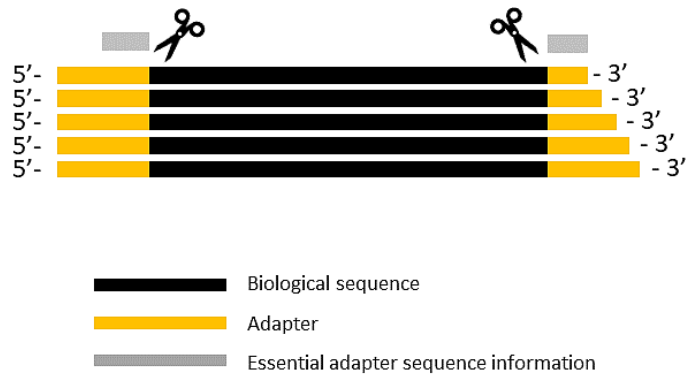
Figure 1. Essential information on adapter sequences for e ff ective trimming process. The 5 (cid:48) end adapter is usually of constant length, while the lengths of 3 (cid:48) end adapters may vary in a dataset. The exact match to the 3 (cid:48) end (tail part, adjacent to a biological sequence) of the 5 (cid:48) end adapter, and to the 5 (cid:48) end (head part, adjacent to a biological sequence) are required to identify the adapters. In the latter case, the shortest variant of the 3 (cid:48) end adapter su ffi ces.